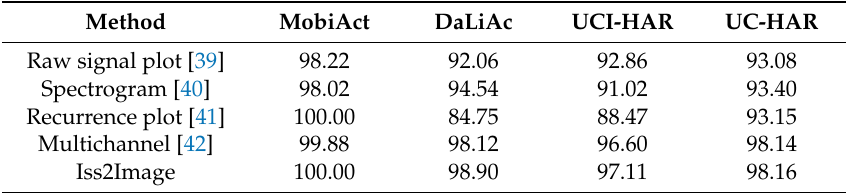
Table 4. Average recognition accuracy (%) comparison of the different transformation methods with the different datasets.